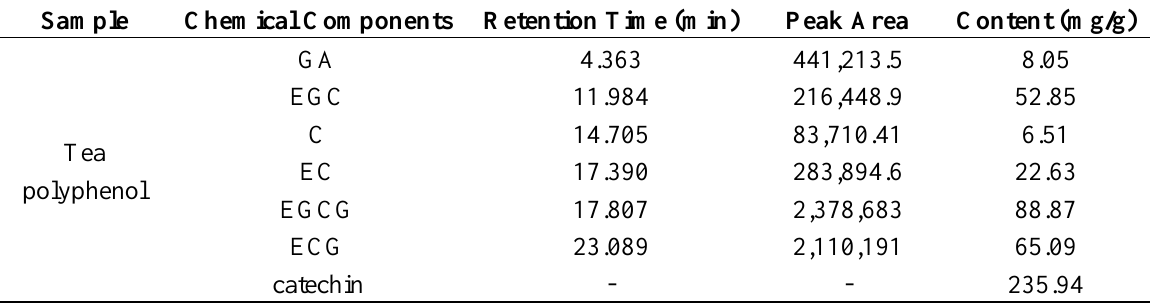
Table 1. High Performance Liquid Chromatography analysis of tea polyphenol.